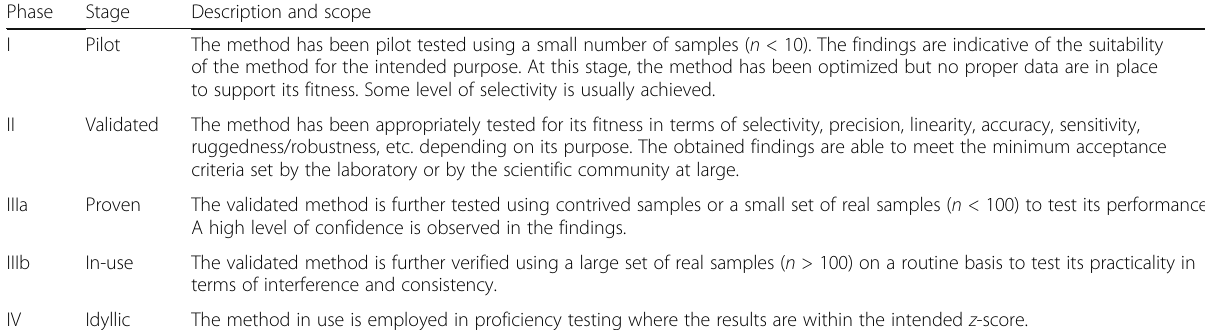
Table 1 Four phases for a forensic chemical method to describe its